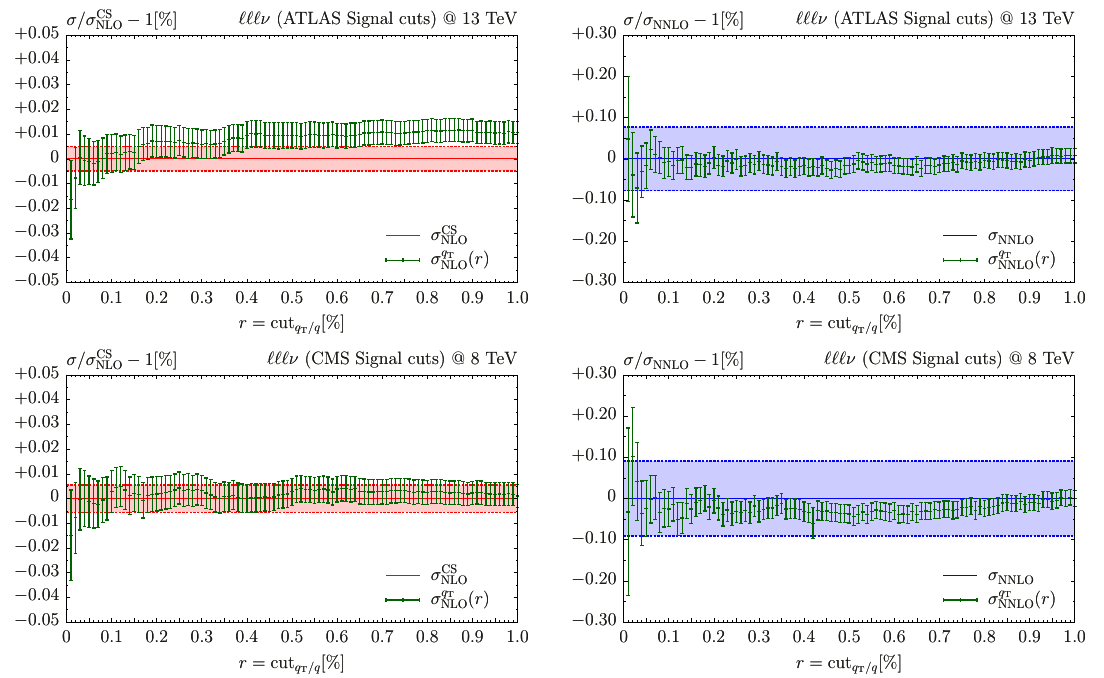
Figure 2 . Dependence of the pp ‘ 0(cid:6) (cid:23) ‘ ‘ (cid:0) ‘ + + X cross sections on the q T -subtraction cut, r cut , 0 ! for both NLO (left plots) and NNLO (right plots) results in the ATLAS signal region at 13 TeV (upper plots) and in the CMS signal region at 8 TeV cuts (lower plots). NLO results are normalized to the r cut -independent NLO cross section computed with Catani-Seymour subtraction, and the NNLO results are normalized to their values at r cut 0, with a conservative extrapolation error ! indicated by the blue